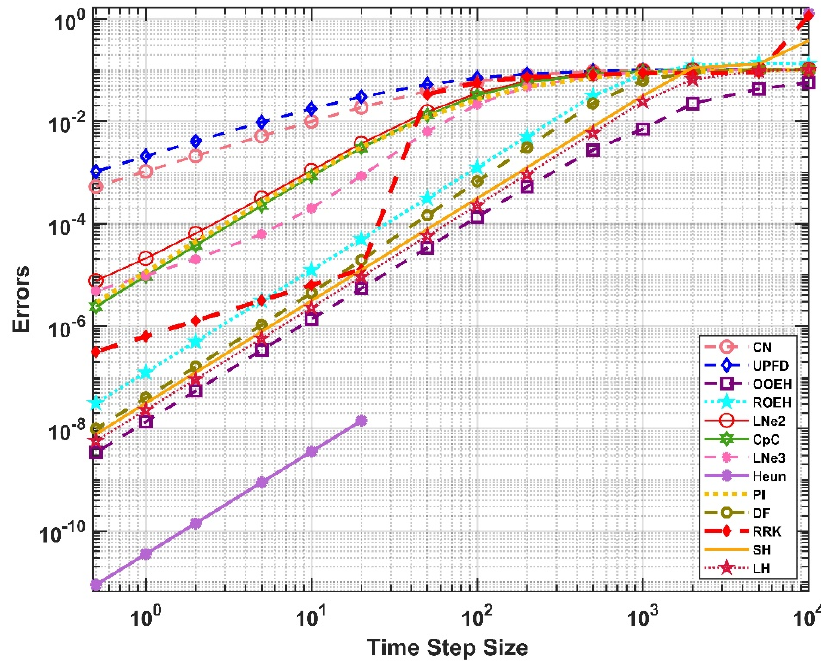
Δ Δ for equidistant mesh. for equidistant mesh.